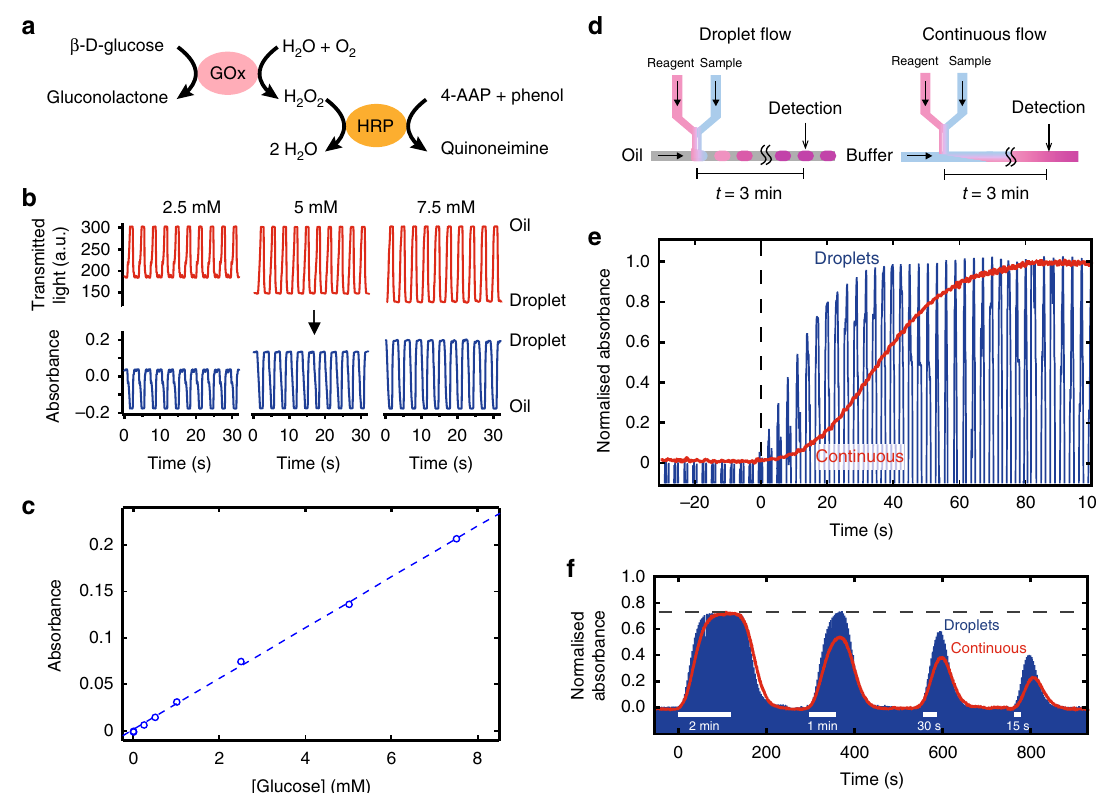
Fig. 3 Glucose assay and sensor calibration. a The reaction mechanism for the glucose assay. Glucose is broken down by glucose oxidase (GOx) to yield gluconolactone and hydrogen peroxide (H 2 O 2 ), which is then catalysed by horseradish peroxidase (HRP) in the presence of phenol and 4-aminoantipyrine (4-AAP) to form a red-violet coloured product quinoneimine. b Examples of raw data from the fl ow cell (top) converted to absorbance (bottom) using a pre-recorded blank measurement of droplets with 0 mM sample. c The measured absorbance was linear with respect to glucose concentration up to 8 mM. d Flow schematic diagram for droplet fl ow (left) and continuous fl ow (right) experiments. e Comparison of the sensor ’ s temporal response to a concentration step change when operating in droplets (blue) and continuous fl ow (red). In droplet fl ow, it took 38 s, or 13 droplets, to reach the step plateau whilst the continuous stream took 80 s. f Comparison of dynamic in vitro microdialysis response when operating in droplets (blue) and continuous fl ow (red). For microdialysis sampling, we imposed concentration change at the probe of varying durations, from 2 min to 30 s, to simulate transient events in tissues. The response is normalised relative to the response obtained when the glucose solution was directly aspirated, bypassing the